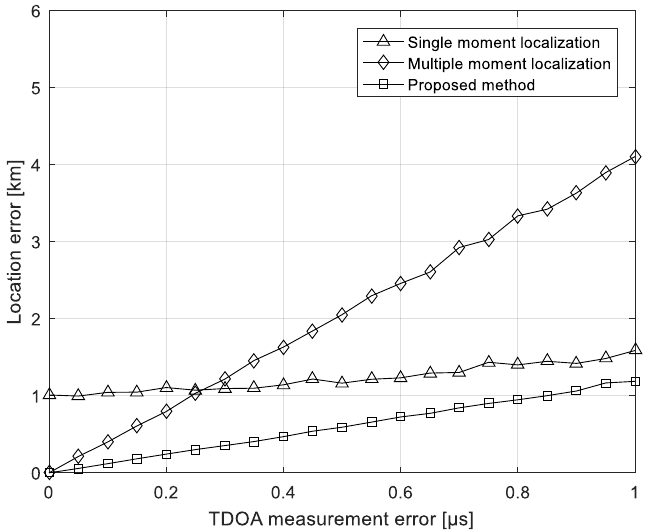
Figure 6. Localization errors versus the TDOA measure errors.